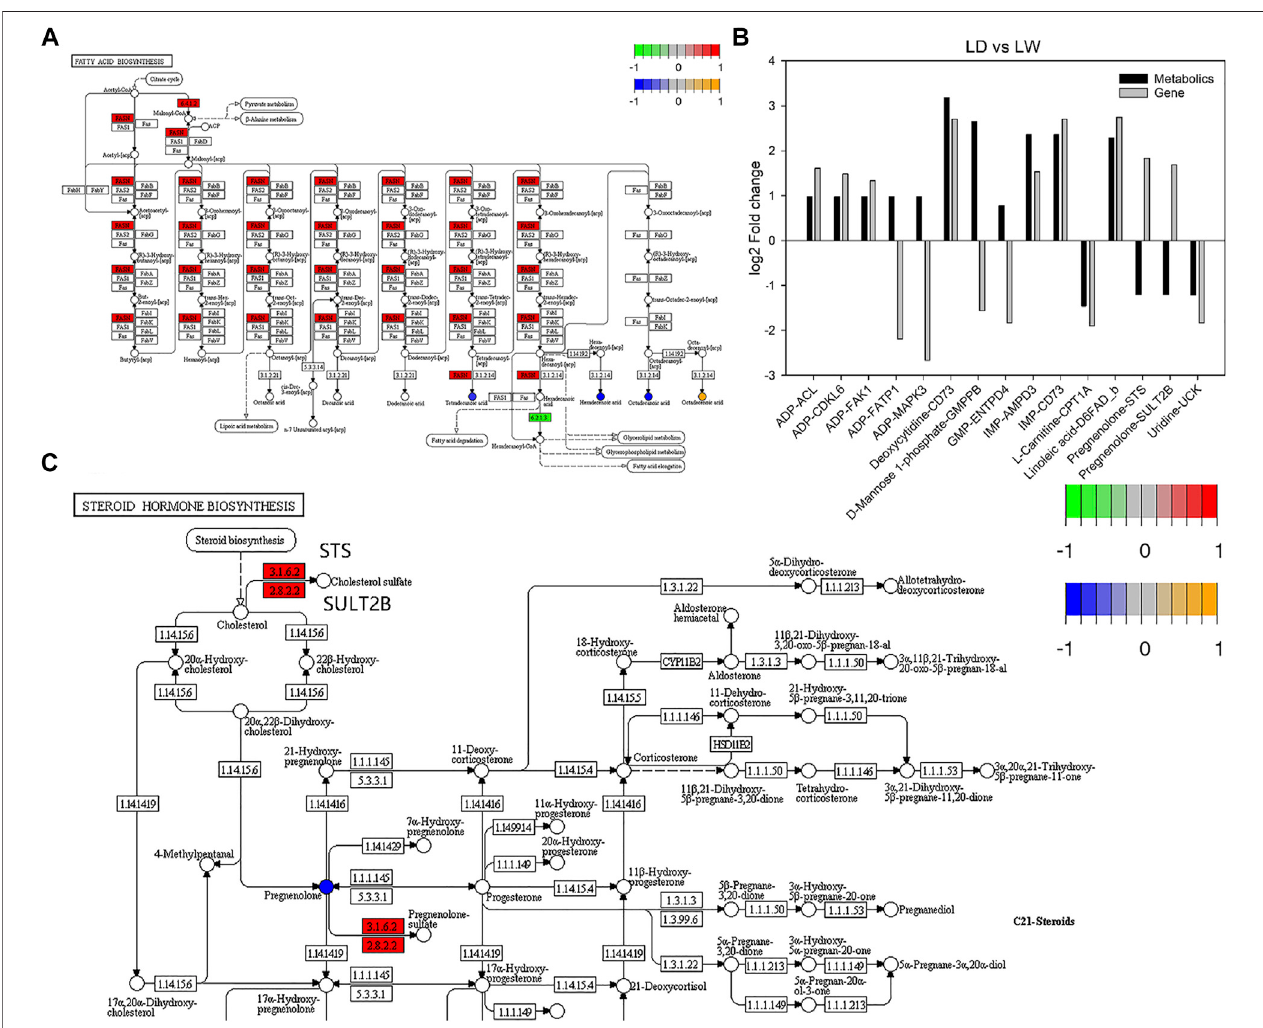
FIGURE 8 | Integrated analysis of the accumulated metabolites (DAMs) and differently expressed genes (DEGs). (A) Fatty acid synthesis pathway. (B) Top 15 metabolite-gene pairs between LD and LW. (C) Part of steroid hormone biosynthesis pathway. The round nodes are metabolites, and the square nodes are the enzymescorrespondingtothetranscripts.Theexpressionfoldchangeofmetabolitesfromlowtohighisrepresentedbybluetoyellow,andtheexpressionfoldchangeof transcripts from low to high is represented by green to red. ADP, adenosine monophosphate; GMP, guanosine 5 ′ -monophosphate; IMP, inosine 5 ′ - monophosphate; ACL , ATP-citrate synthase; AMPD3 , AMP deaminase 3-like; CDKL6 , cyclin-dependent kinase 6-like; CPT1A , carnitine O-palmitoyltransferase 1, liver isoform; D6FAD_b , delta-6 fatty acyl desaturase; ENTPD4 , ectonucleoside triphosphate diphosphohydrolase 4-like; FAK1 , focal adhesion kinase 1; FATP1 , long-chain fattyacidtransportprotein1; GMPPB ,mannose-1-phosphateguanyltransferasebeta; MAPK3 ,mitogen-activatedproteinkinase-activatedproteinkinase3; STS ,steryl- sulfatase; SULT2B , alcohol sulfotransferase; UCK , uridine-cytidine kinase; EC:2.8.2.2, SULT2B; EC:3.1.6.2,